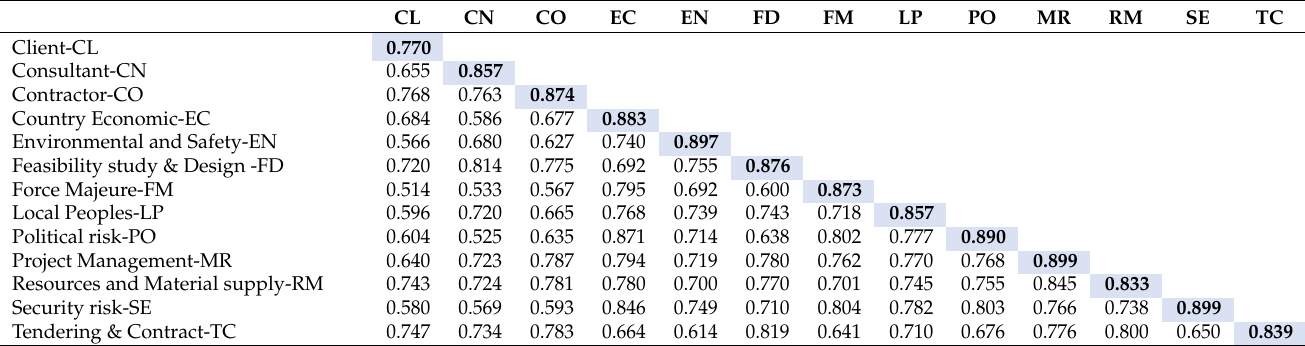
Table 9. Discriminant validity Fornell–Larcker risk